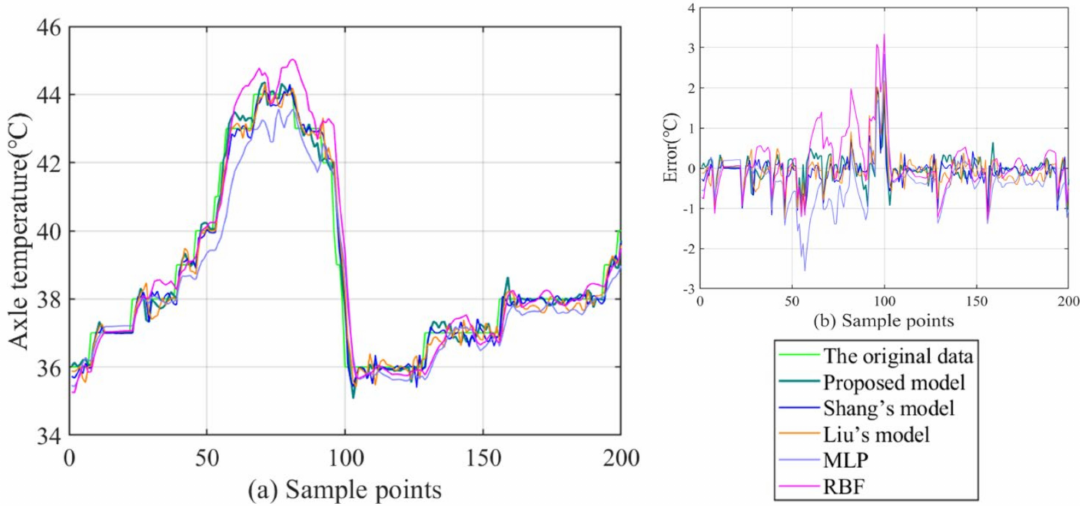
Figure 15. Prediction results and errors of series #3: ( a ) prediction results; ( b ) error